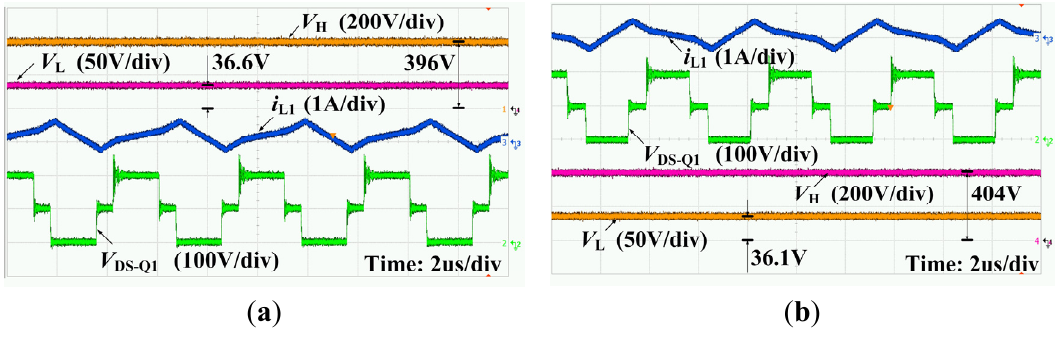
Figure 19. Experimental results in light-load condition ( a ) 36 V input and 400 V/10 k Ohm output; ( b ) 400 V input and 36 V/100 Ohm